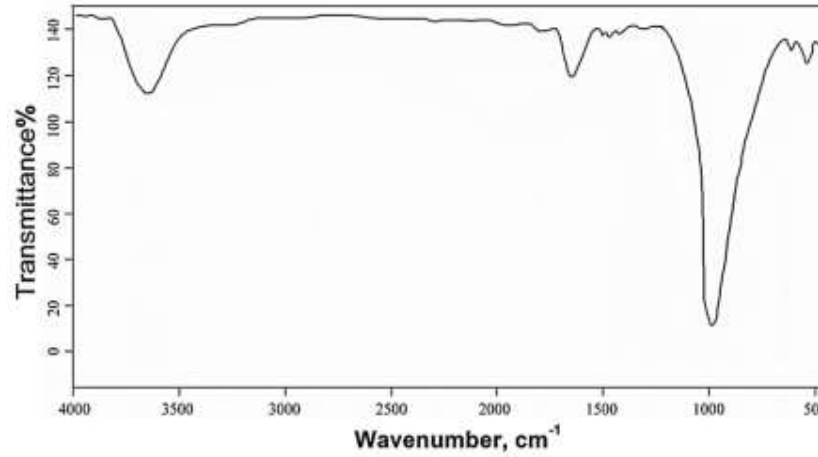
Figure 4: FTIR analysis was used to determine the functional groups of Al